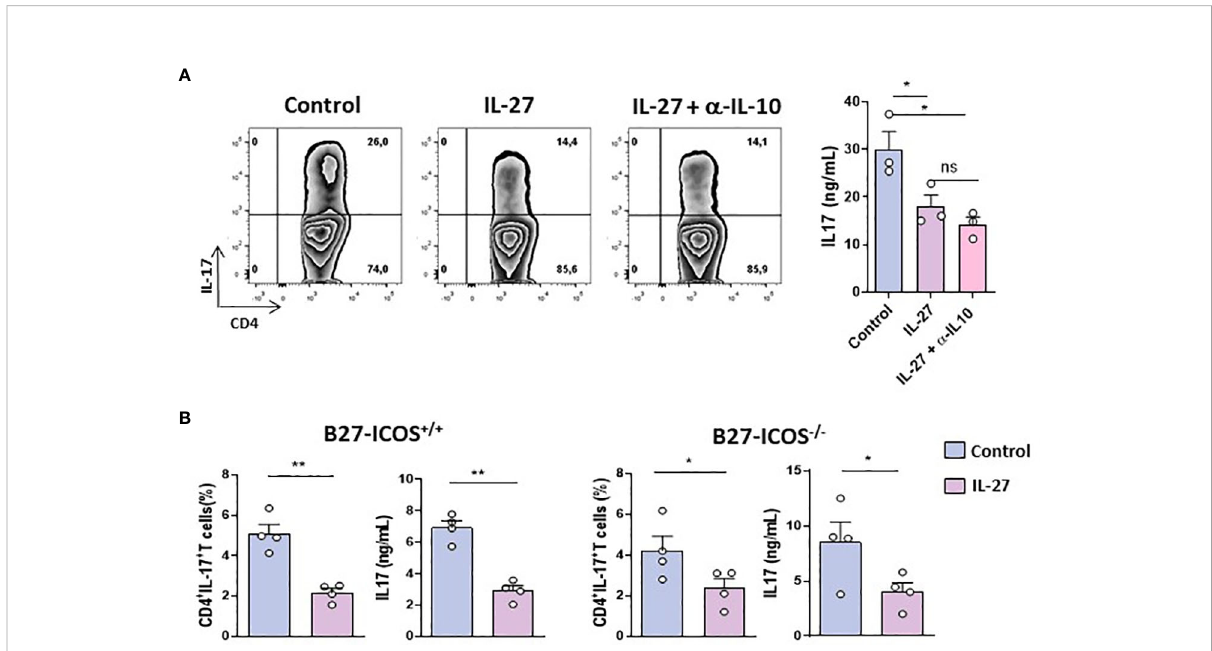
FIGURE 2 IL-27 inhibitory effect on B27-T cells is IL-10/ICOS independent. (A) Left: Representative dot-plot of IL-17 + cells among activated CD4 + CD25 + T cells from B27-rat aged of 5 months cultured for 3 days with coated anti-CD3 in the presence or absence of IL-27 and anti-IL-10 blocking antibody. Right panel: level of IL-17 in culture supernatants (3 rats/group). (B) CD4 + CD25 + T cells from ICOS +/+ or ICOS -/- B27- rats (aged of 9- 11 months) cultured for 3 days with coated anti-CD3 in the presence or not of rmIL-27. Histograms represent the mean + SEM of 3-4 rats/ group. IL-17 and IL-10 concentrations were evaluated by ELISA. *p < 0.05; **p < 0.01. ns, not signi fi